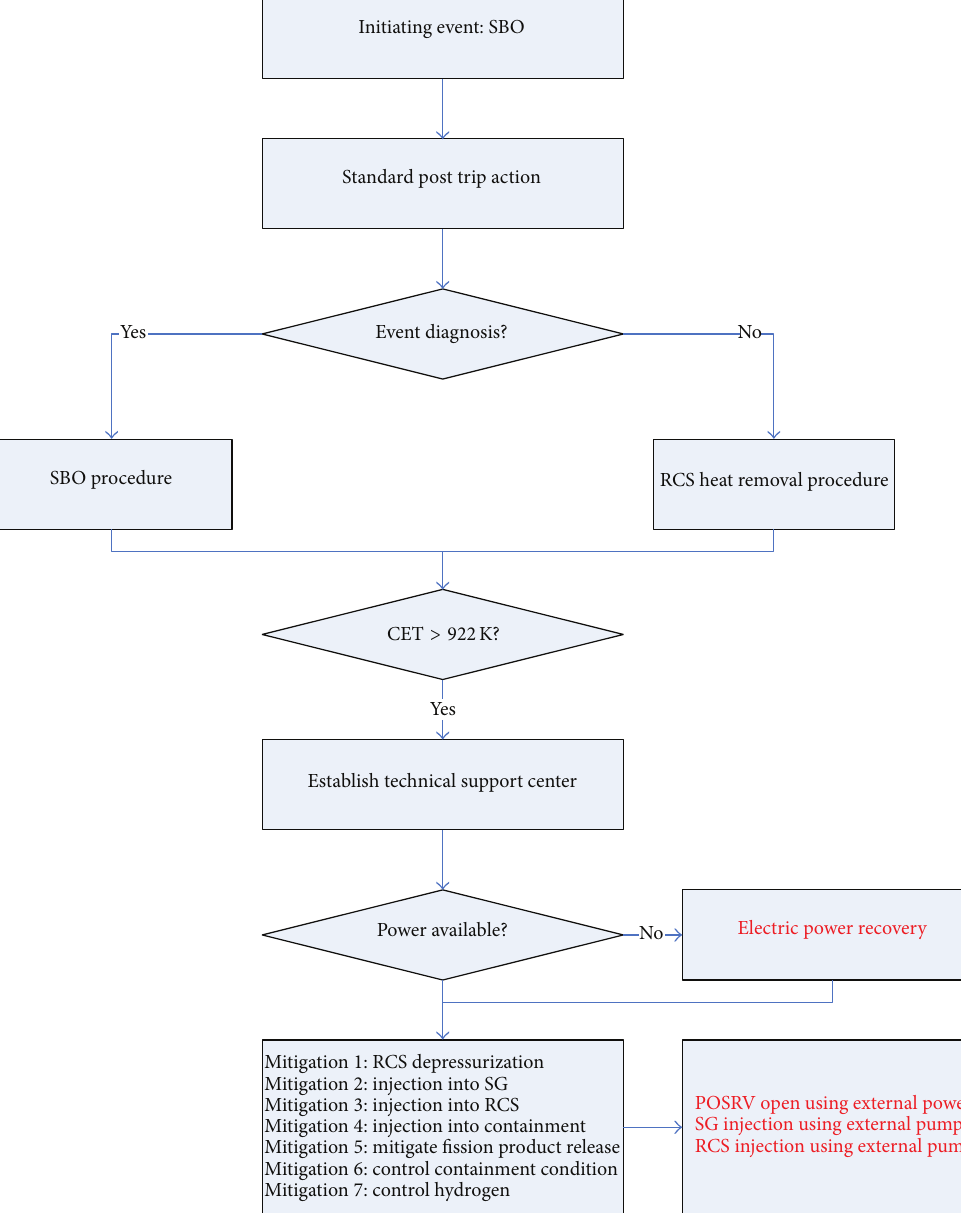
Figure 1: Flowchart of the SBO related